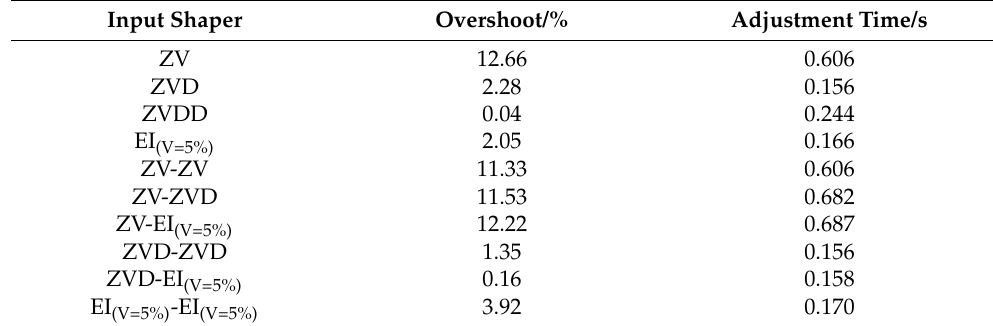
Table 5. Performance of each input shaper at 10% error value.